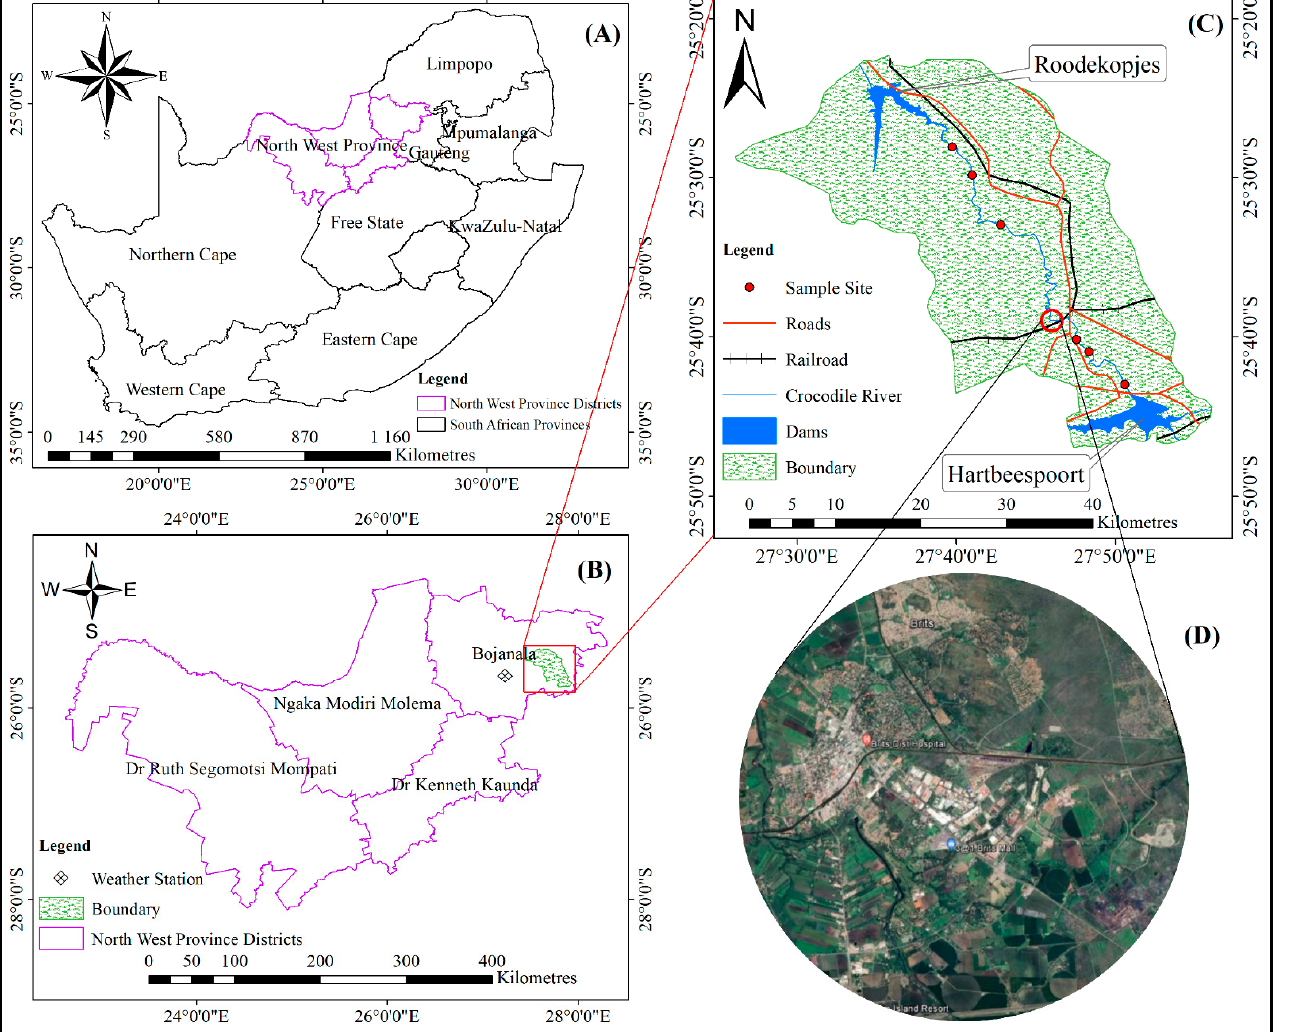
Figure 2. Map of the study area: ( A ) shows the map of South Africa, ( B ) shows the different prov- inces in South Africa, ( C ) shows the study catchment area and ( D ) shows a zoomed-out area of the different land uses.